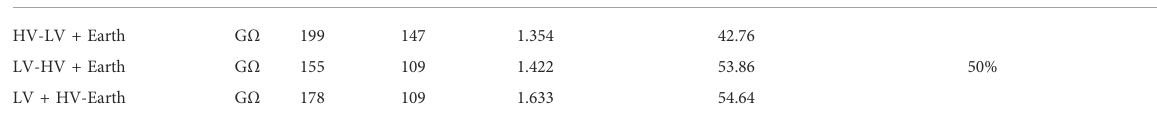
Table 3 identi fi es the type of fault based on the output of Duval triangle 1. Each fault type is designated by a speci fi c fault symbol. For example, if the output of Duval triangle is between 28.58 and 42.86, then the fault type is thermal fault T1,